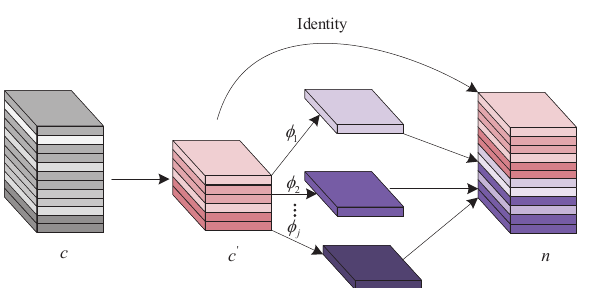
Figure 2. Framework of ghost modules. c , c (cid:48) , and n represent the number of input feature channels, the number of intrinsic features, and the number of output features,